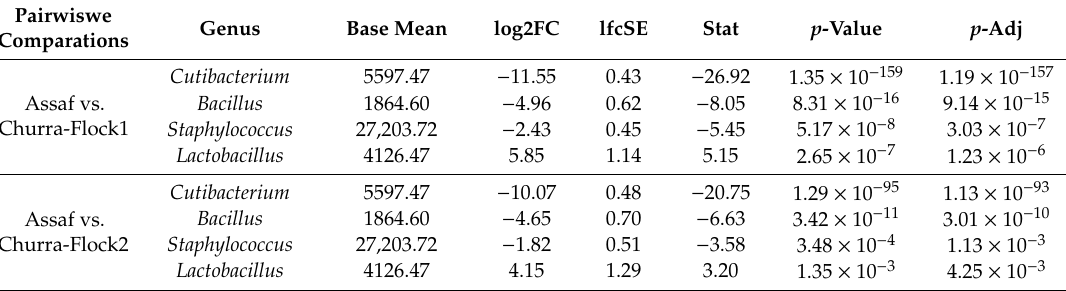
Assaf vs. Churra-Flock2